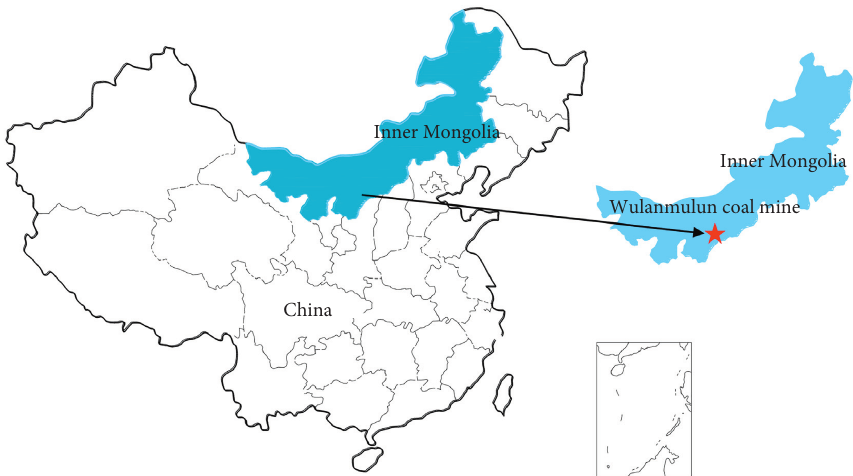
Figure 1: Traffic location map of Wulanmulun coal mine.